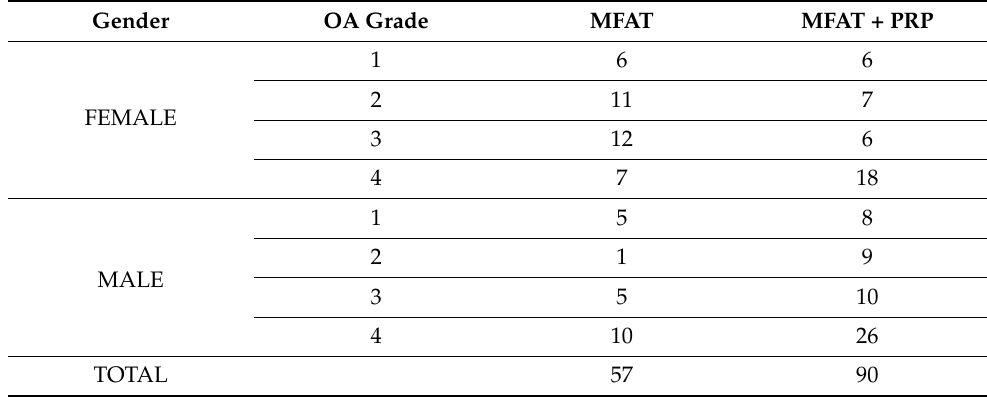
Table 2. Number of patients in each group according to treatment and grade of